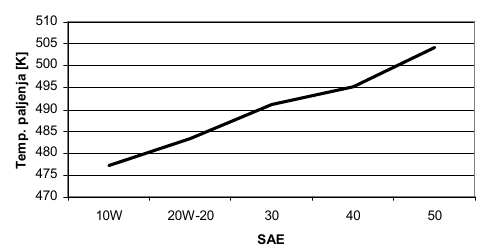
Sl. 6 – Temperature paljenja za neke vrste ulja